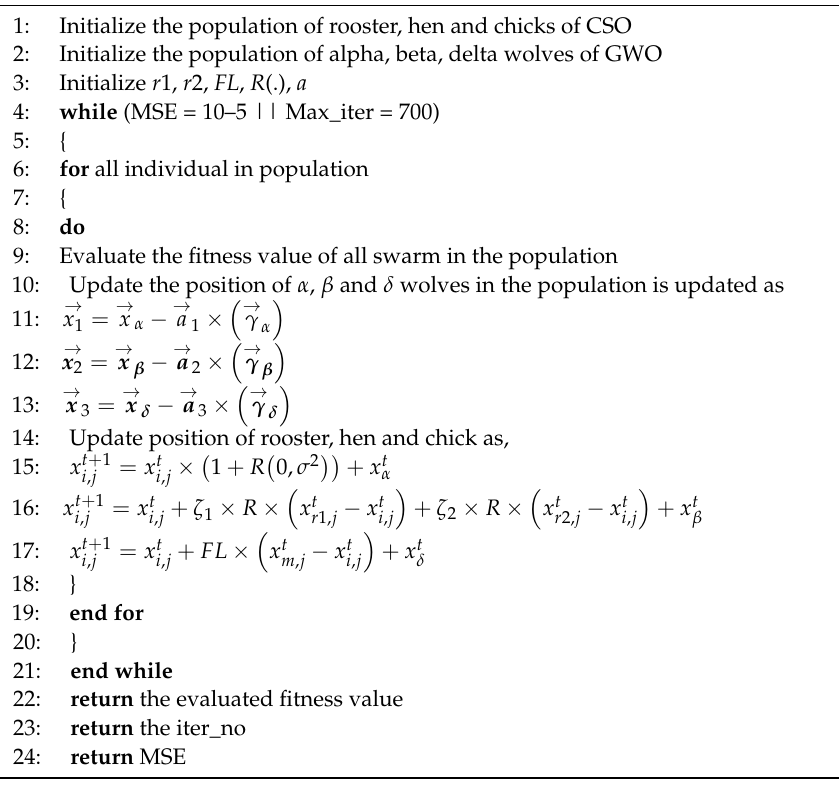
Algorithm 1 Proposed hybrid CSO-GWO